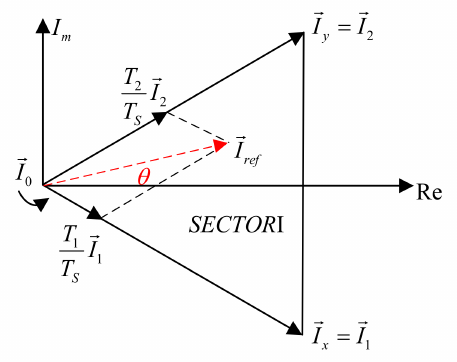
Figure 3. Synthesis principle of reference vector I ref